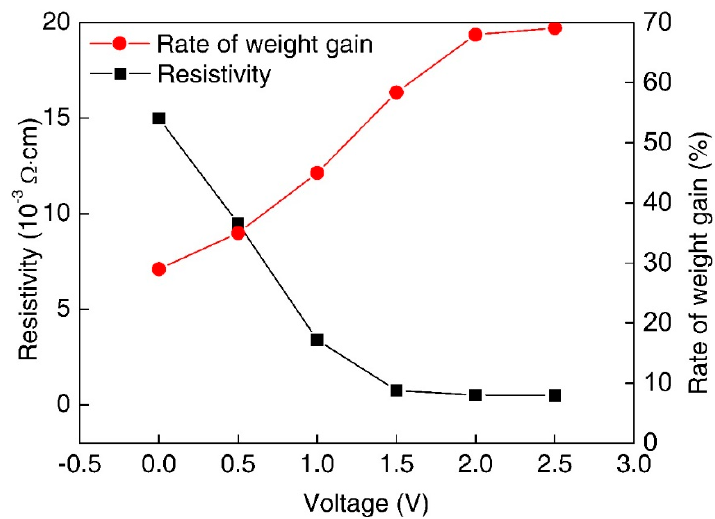
Figure 3. Influence of voltage on the resistivity and the rate of weight gain.